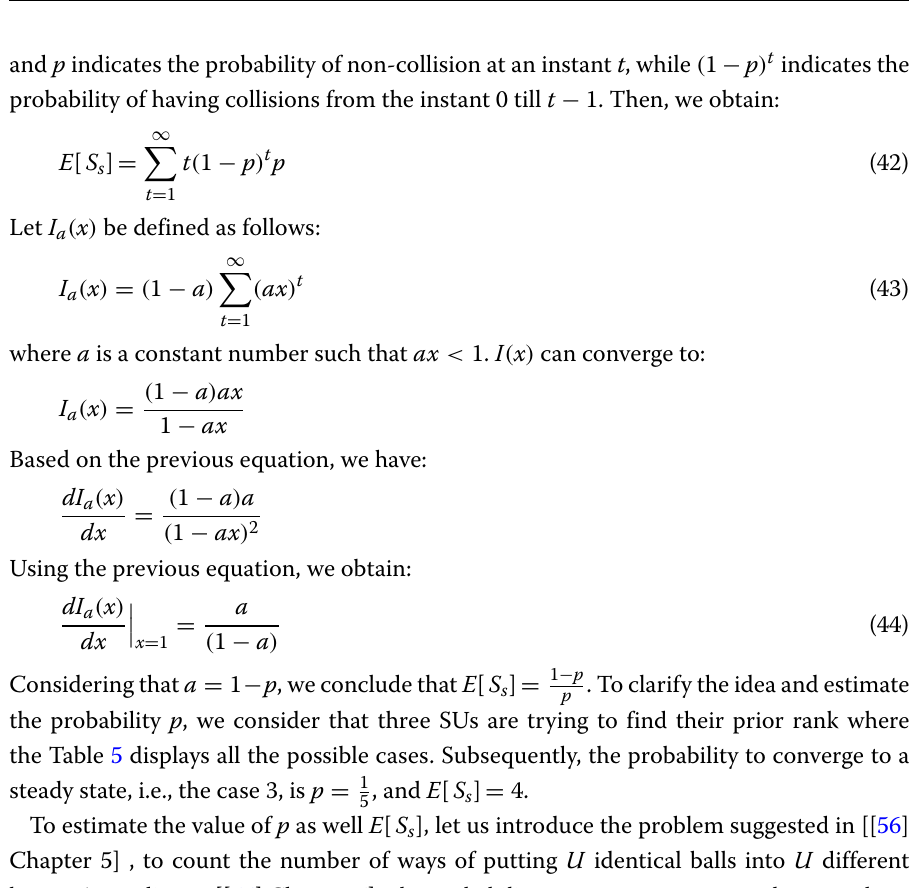
Table 5 Three SUs trying to converge towards a steady state where each one finds its prior rank. The roman number indicates the number of users selecting the same rank Cases Rank 1 Rank 2 Rank 3 1 | || 0 2 ||| 0 0 3 | | | 4 || | 0 5 ||